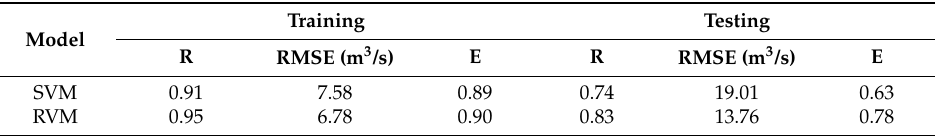
Table 5. Results of indices used to evaluate the performance of the relevance vector machine (RVM) and support vector machine (SVM) model for streamflow forecasting in the Dahuofang Reservoir. Training Testing Model R RMSE (m 3 /s)